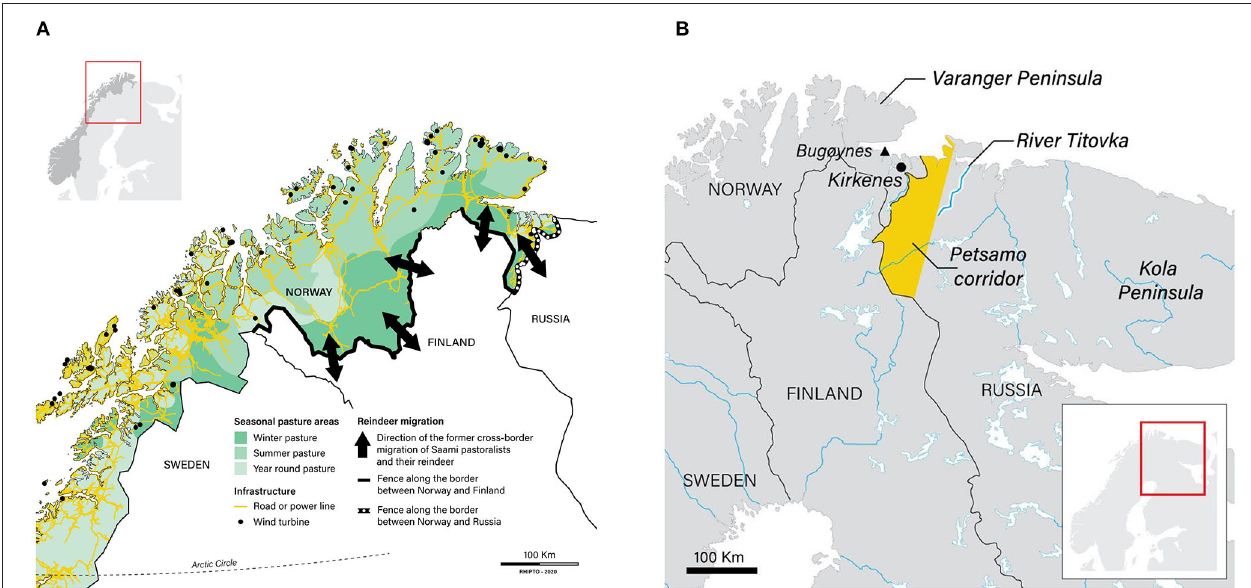
FIGURE 20 | Legal constraints and infrastructure reduce land available for pastoralism. (A) Map showing fences (thick lines) built along the border between Norway and Russia (fence 200km in length) and between Norway and Finland (fence 637km in length) to prevent cross-border grazing by domesticated reindeer. Heavy black arrows indicate the direction of seasonal migration of reindeer before the borders were closed. The map also shows infrastructure (roads and wind turbines) on seasonal reindeer pasture in northern Norway. Infrastructure and related features that substantially reduce the area of reindeer pasture not shown here include agricultural land, airports, hydro-electricity plant (including flooded ground), industrial plant, military training areas, mines and recreational facilities including private huts, ski fields and walking-, dog-driving, ski- and snowmobile-trails. (B) Map showing places mentioned in the text regarding the consequences for reindeer husbandry of the closure of the border with Russia. Sources: Roto (2015) and Government of Norway (2016), Norwegian Mapping Authority.